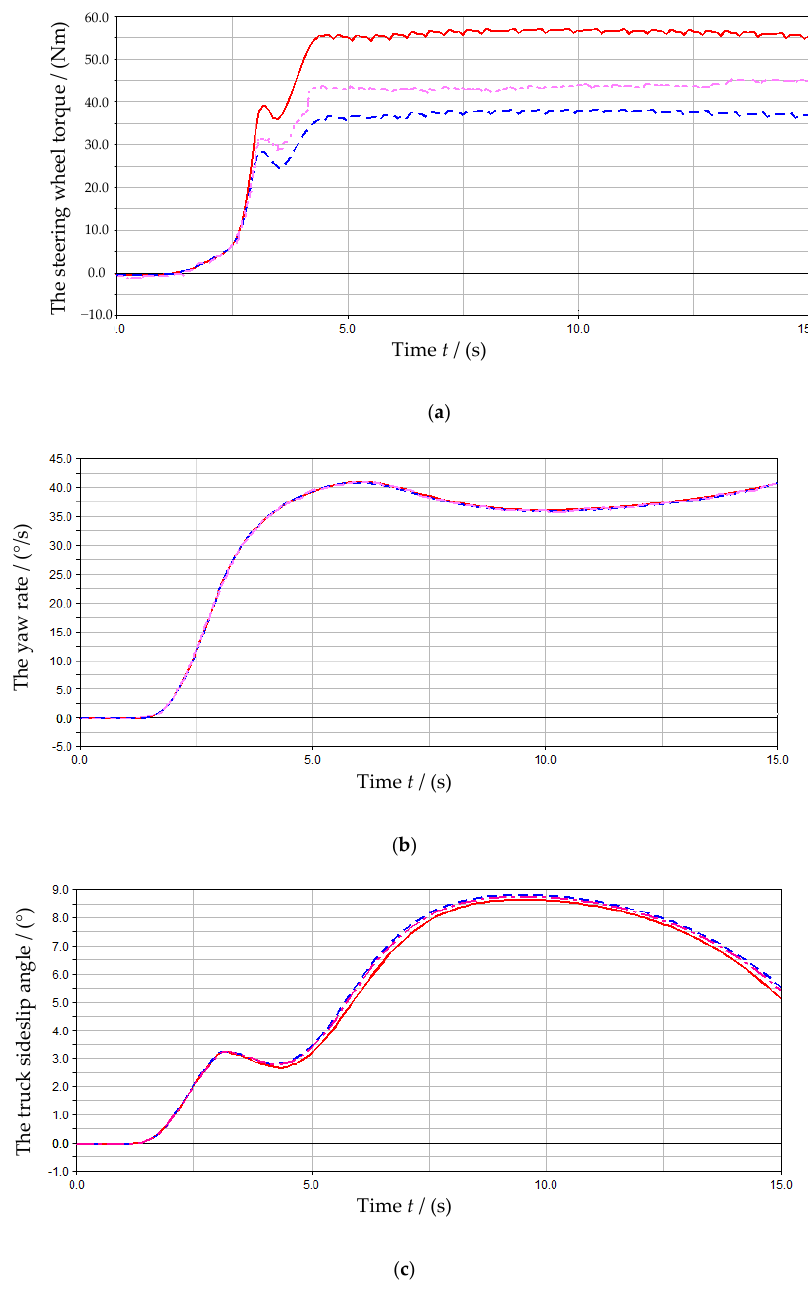
Figure 17. A comparison of the simulated dynamic responses obtained from the drift tests: ( a ) The steering wheel torque, ( b ) the yaw rate, and ( c ) the truck sideslip angle.